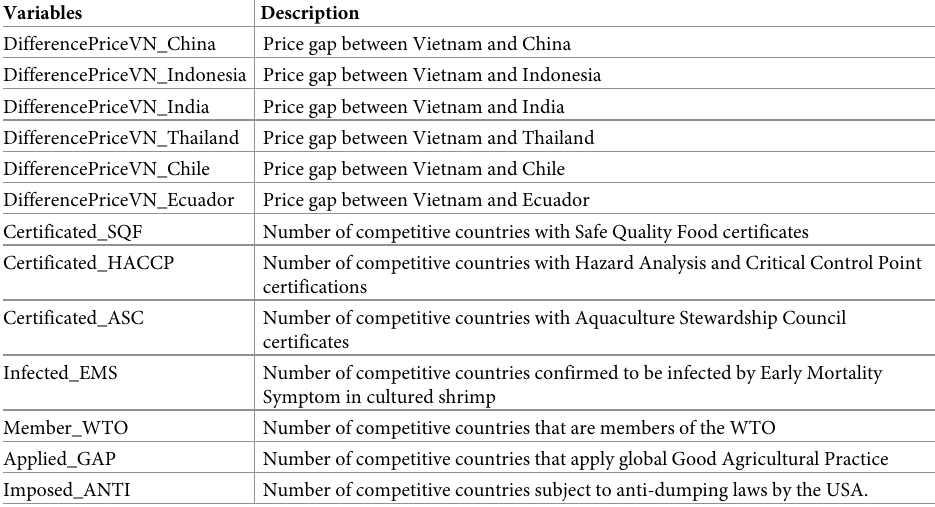
Table 1. List of